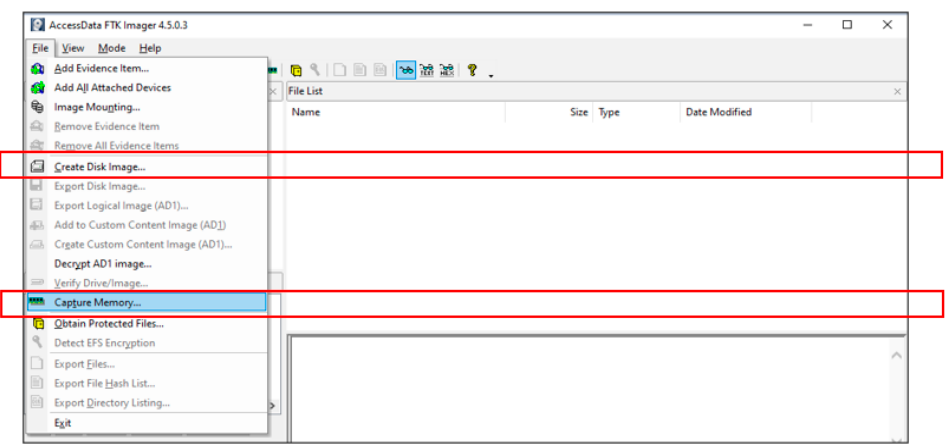
Figure 12. Capturing volatile and nonvolatile data.